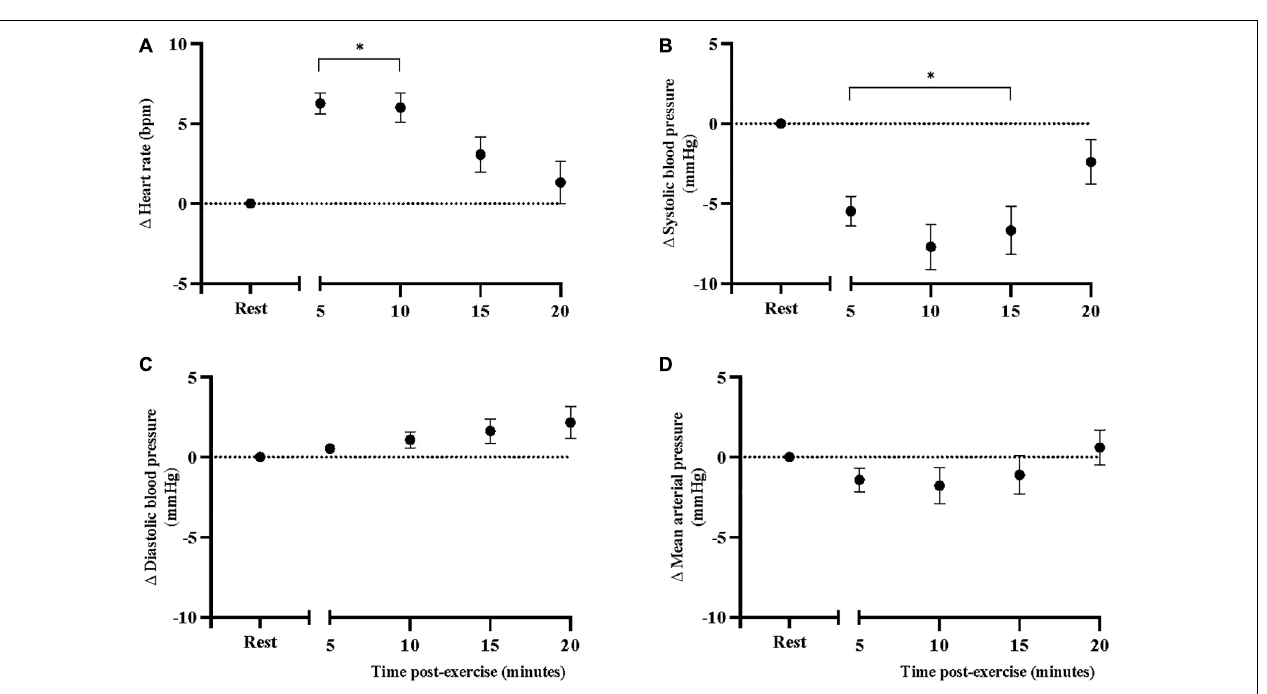
FIGURE 2 | Changes in (A) heart rate, (B) systolic blood pressure, (C) diastolic blood pressure, and (D) mean arterial pressure, at rest and after acute, high-intensity aerobic exercise. Points are presented with standard error. Significantly different from resting values * P <